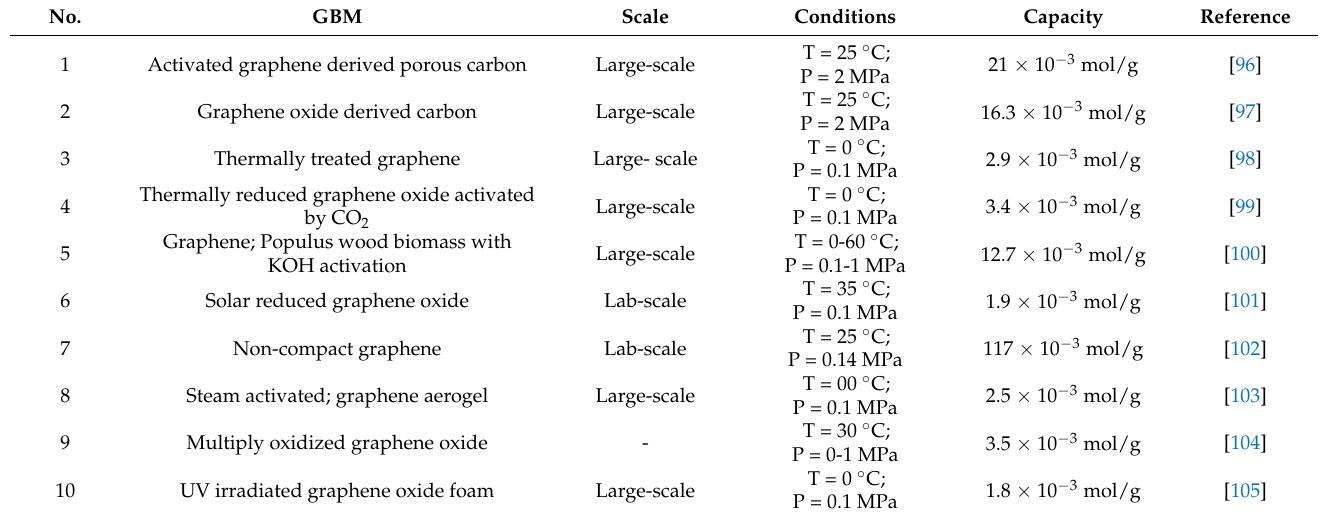
Table 2. List of graphene-based materials (GBM) used for carbon capture technologies for CO 2